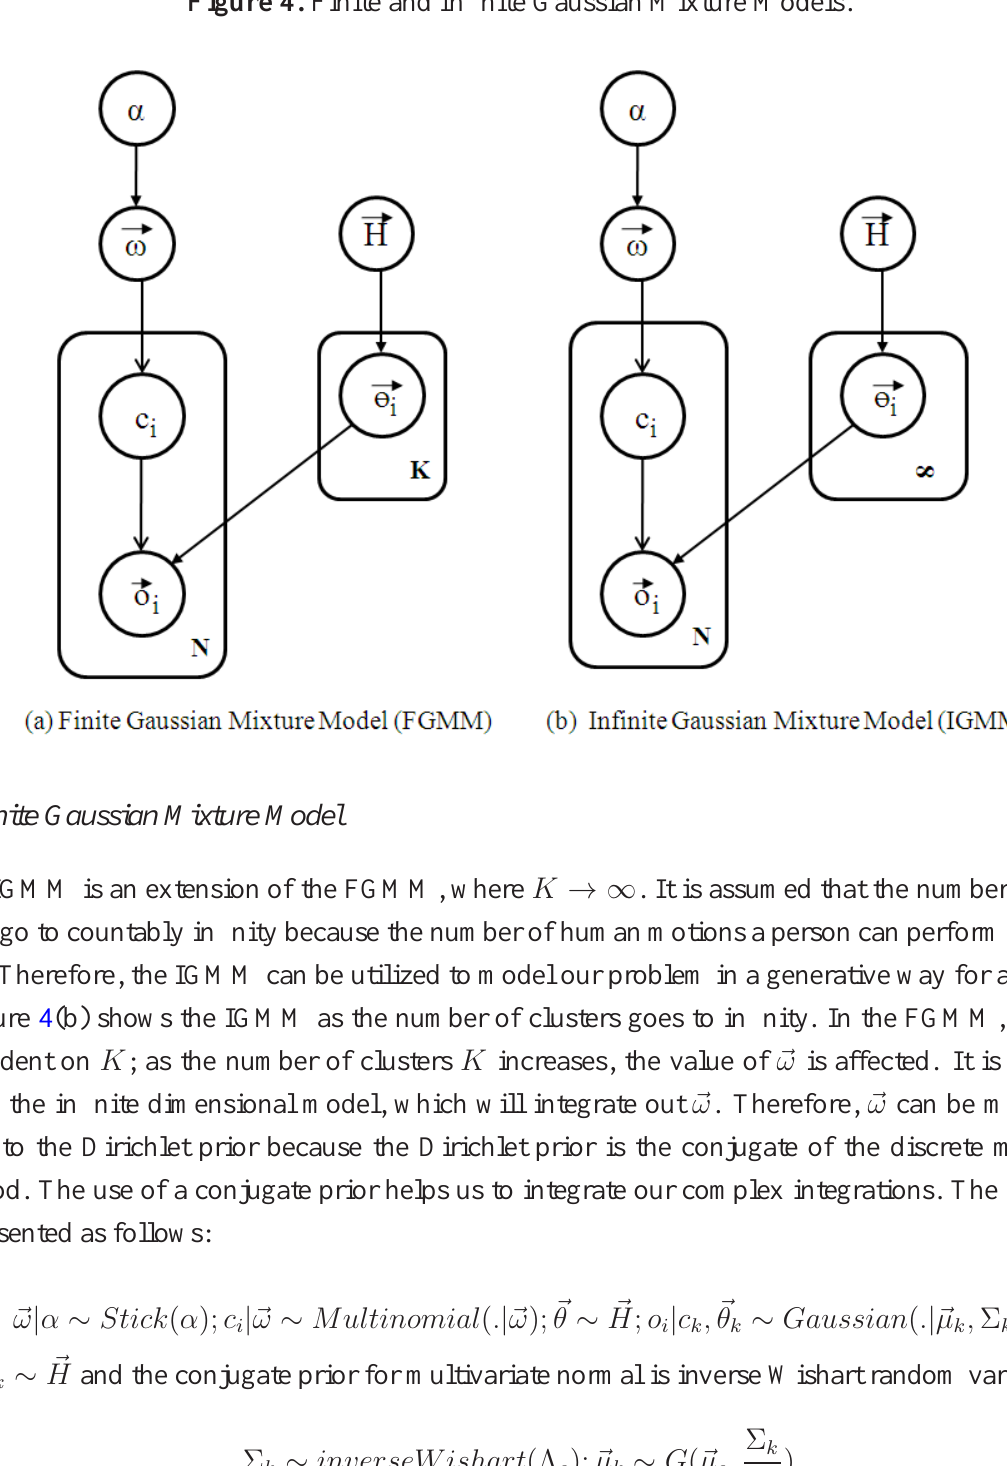
Figure 4. Finite and Infinite Gaussian Mixture